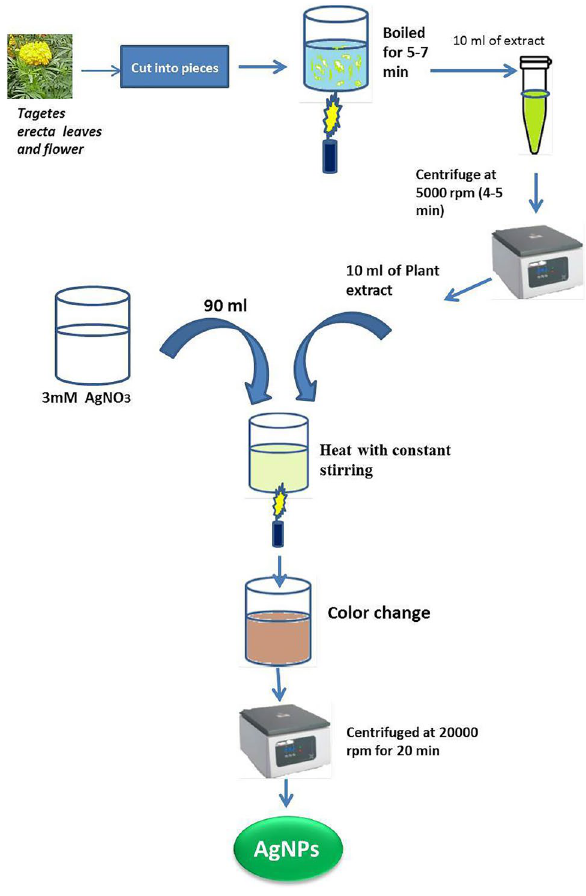
Figure 1. Preparation of silver nanoparticles (AgNPs) from leaves and flowers extract of T.erecta